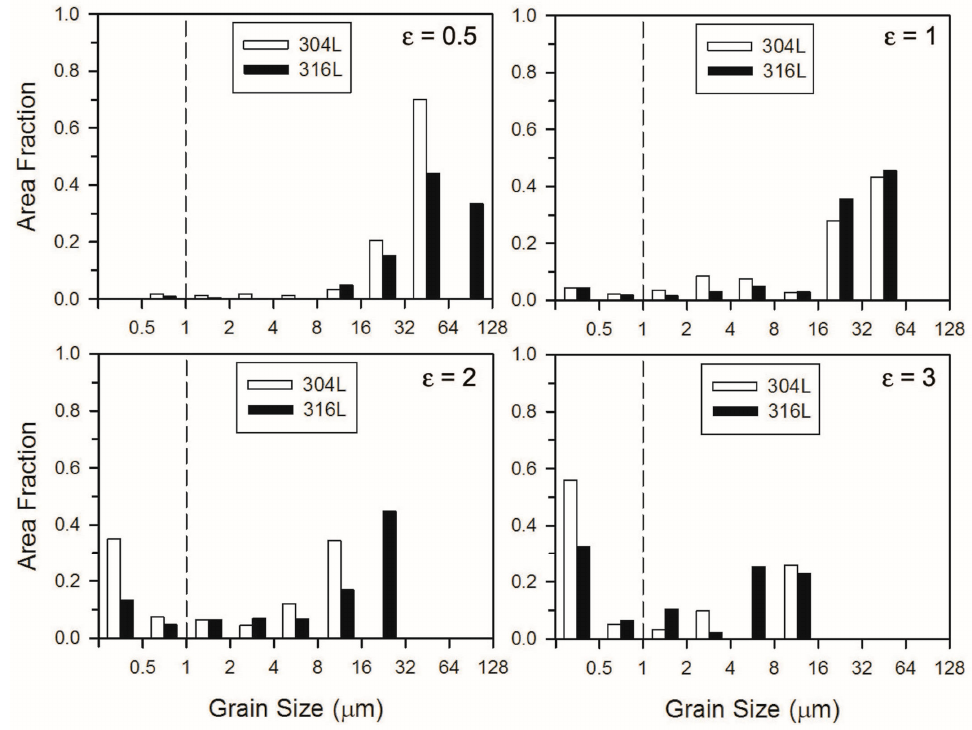
Figure 4. The grain size distributions in 304L and 316L stainless steels subjected to rolling at 473 K to various total strains ( ε ).